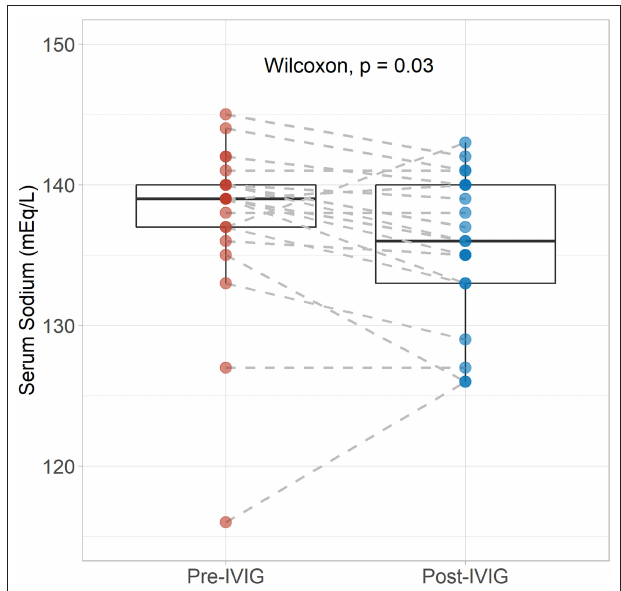
FIGURE 2 | Serum sodium levels before and after completion of treatment with intravenous immunoglobulins. Differences between pre- and post-values in patients receiving IVIG were assessed with the Wilcoxon singed-rank